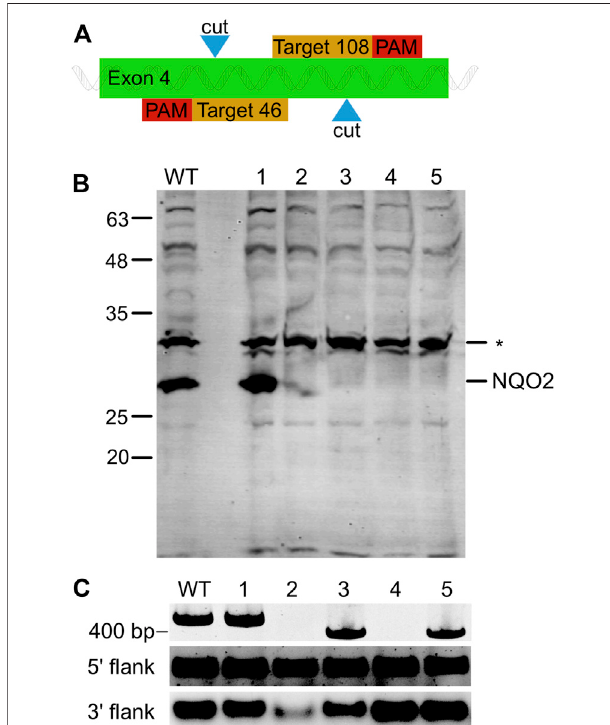
FIGURE 1 | NQO2 Gene Knock-Out in HCT116 using CRISPR/Cas9 Nickase. (A) Illustration of the knockout strategy. The paired guide RNA was designedtogenerate asinglestrand nickat positions46and108ofthefourth exon of NQO2. (B) Western blot of NQO2 in HCT116 (WT) and fi ve knockoutclones(numbered1 – 5)transfectedwiththepairedguideRNA.Four of the clones (2 – 5) had no detectable amount of NQO2. A non-speci fi c band (*) was detected by the polyclonal anti-NQO2 antibody. (C) PCR ampli fi cation of exon 4 of NQO2 in HCT116 and HCT116 Δ NQO2 clones. Clone 1 showed a product size of 425 bp as expected, clones 2 and 4 did not have a PCR product,and clones3and5hadashorter PCRamplicon(top). PCRproducts were separated on a 3% polyacrylamide gel. Regions upstream and downstream of exon 4 were also individually ampli fi ed (bottom). A PCR product was observed for all clones in the 5 ′ fl ank and 3 ′ fl ank regions of exon 4. Thus, the two fl anking regions of exon 4 exist in the genome but are disjointed in clone 2 and 4. PCR products of the fl anking regions were separated on a 1% agarose gel.